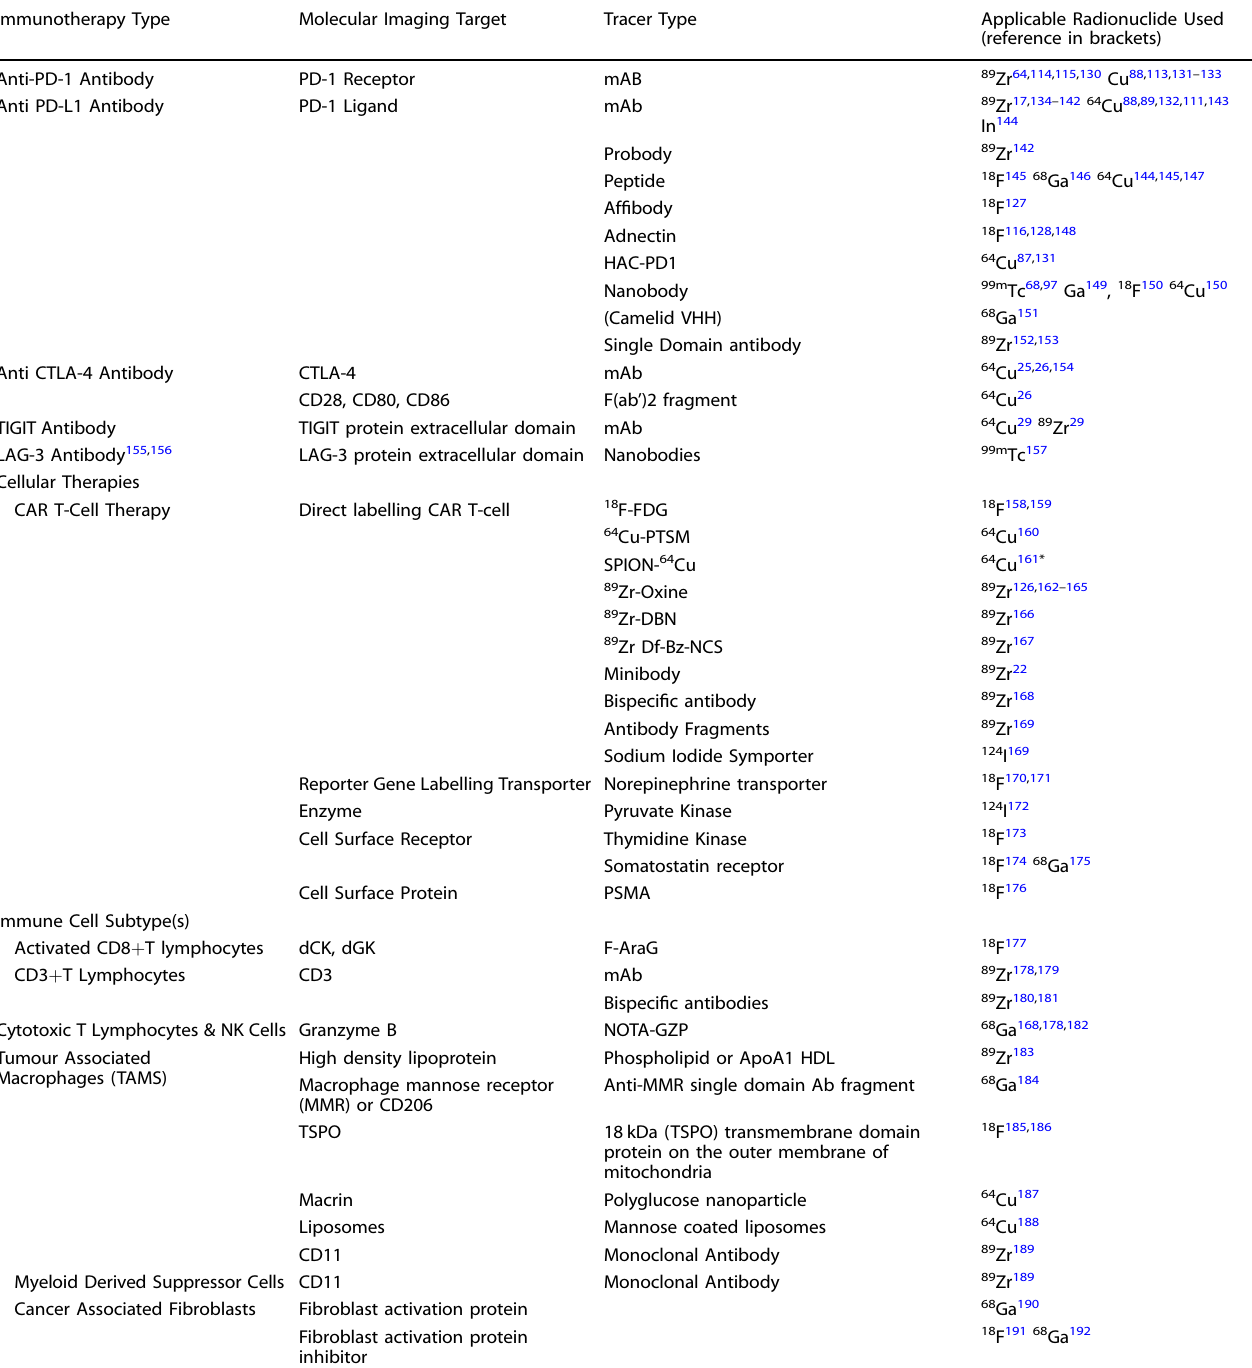
Table 1. Methodologies and radioisotopes used to image immunotherapy